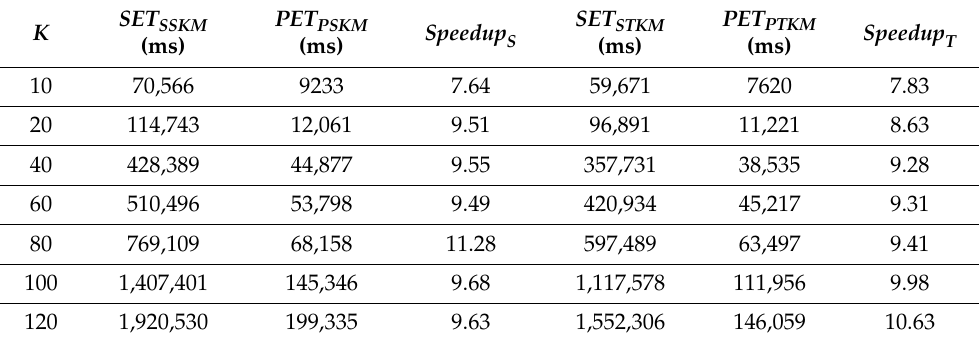
Figure 10. The number of iterations ( 𝑖𝑡 ) for convergence vs. 𝐾 . Table 2. Serial/parallel elapsed times for Stream-based and Theatre-based K-Means vs. K (P = 16).